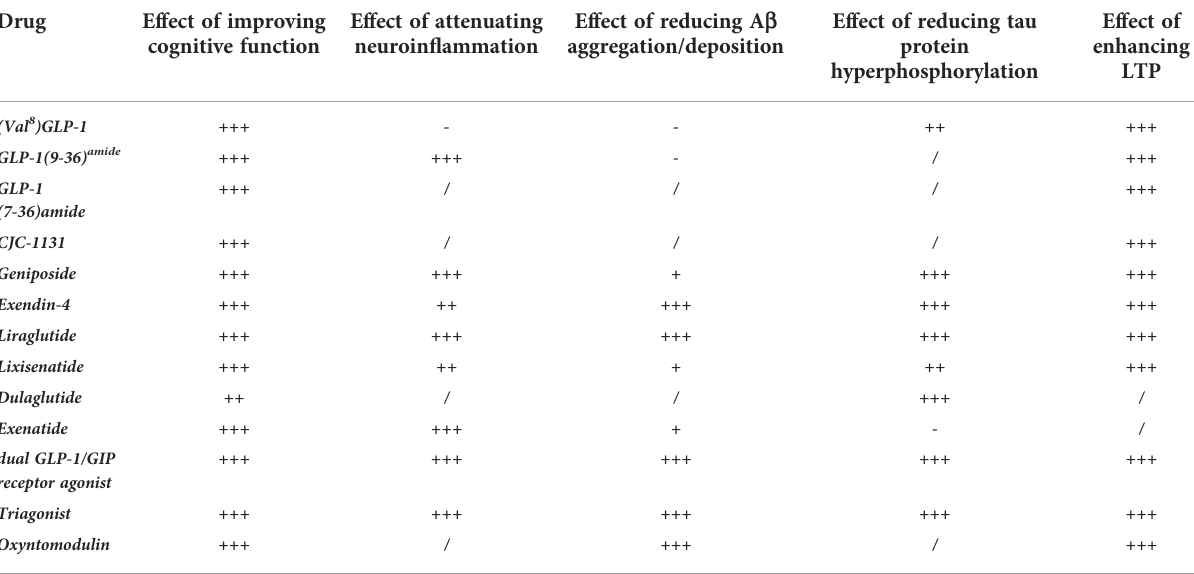
TABLE 1 The effects of various GLP-1R agonists upon brain mechanisms in animal models for AD.